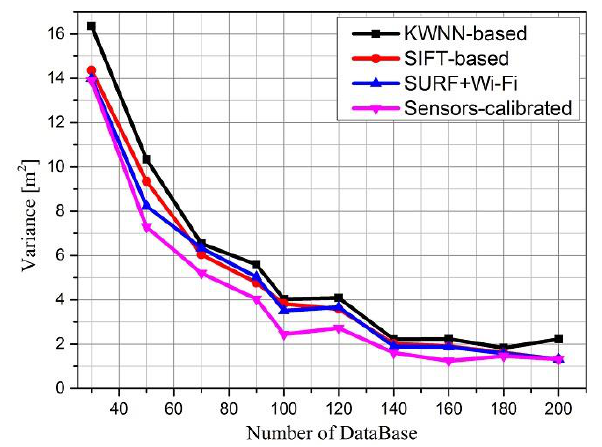
Figure 14. Positioning variance comparison.